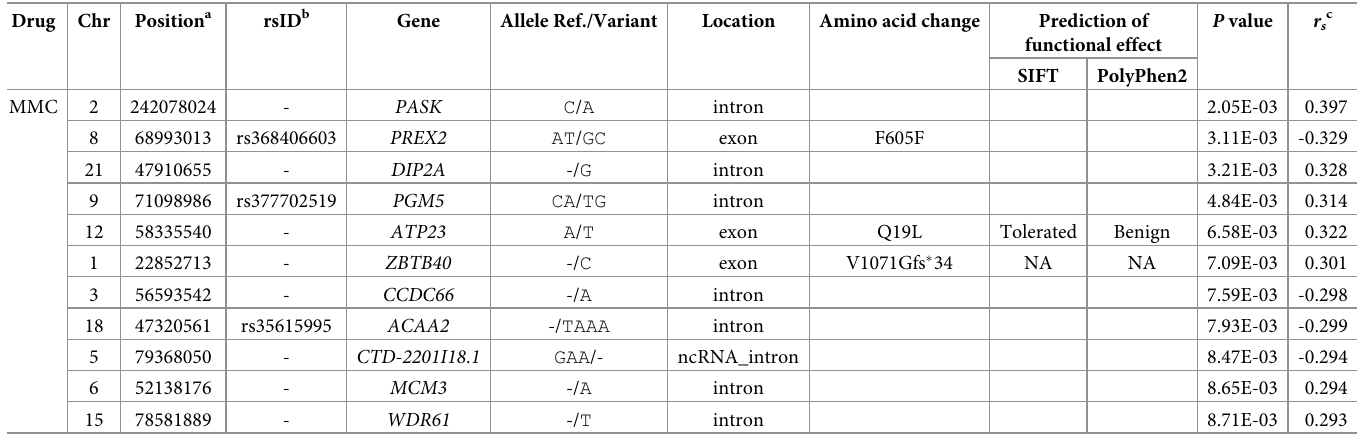
Table 6. Variants associated with chemosensitivity to MMC (P < 0.01), as identified among 79 xenografts. Drug Chr Position a